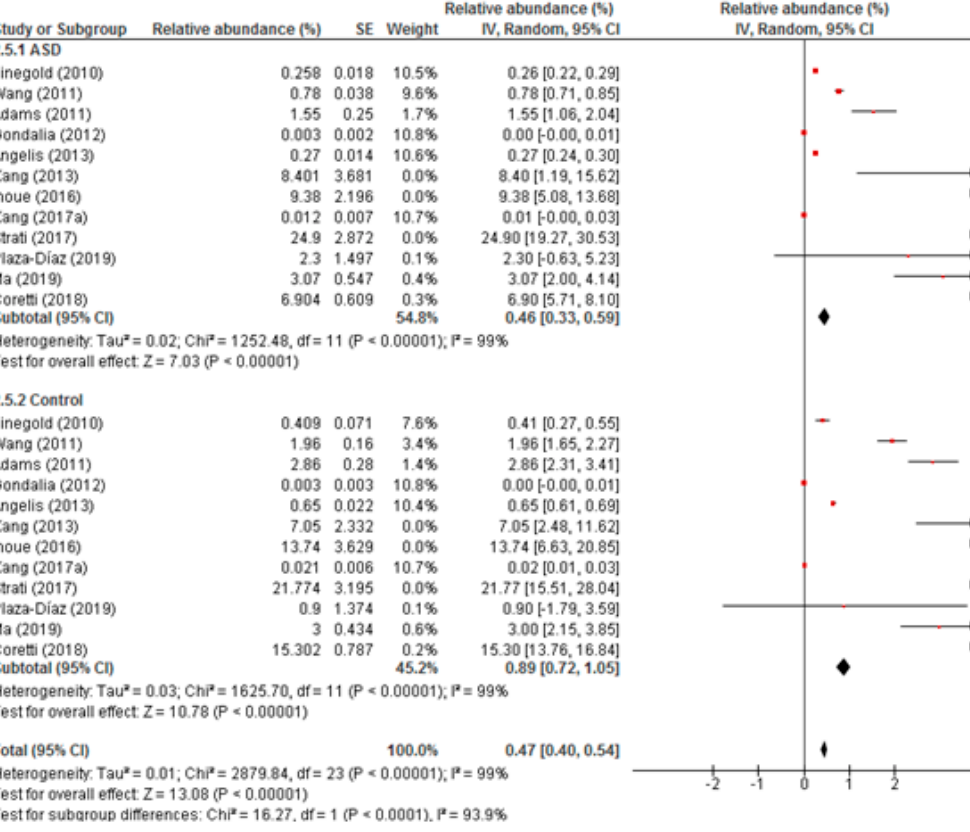
Figure 8. Forest plot of relative abundance of Bifidobacterium in children with ASD and controls.